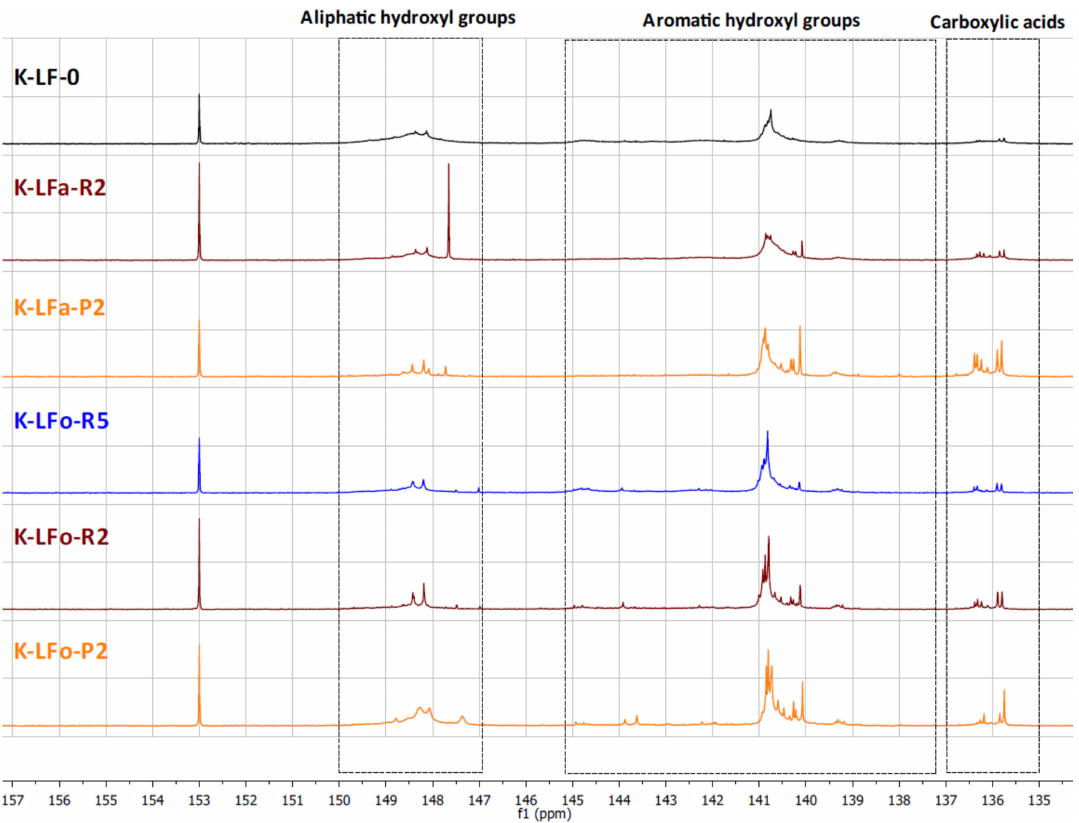
Figure 9. 31 P-NMR spectra of lignin fractions recovered from the aqueous and the organic process applied on